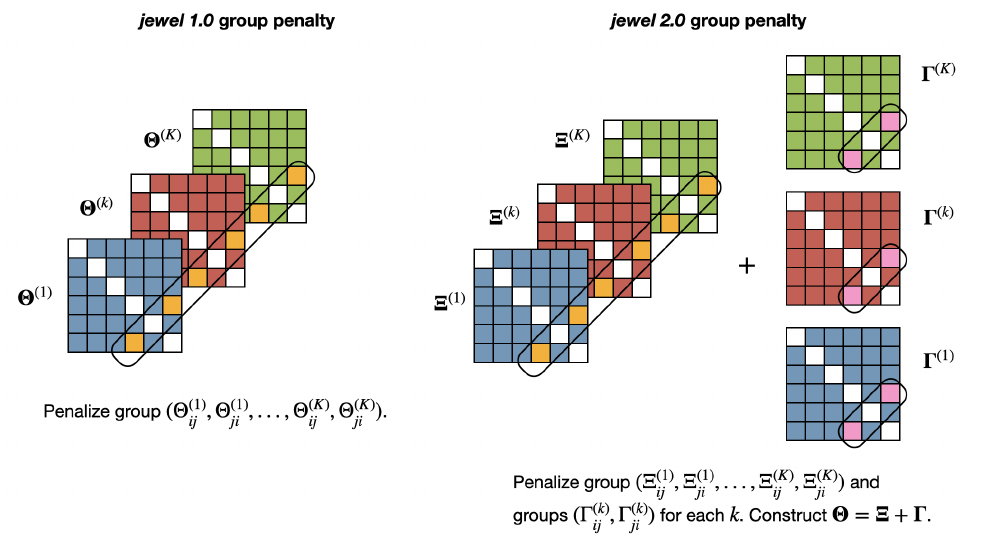
Figure 2. Illustration of the group penalties applied in jewel 1.0 ( left panel ) and jewel 2.0 ( right panel ). In jewel 1.0 , the penalty forces the datasets to share the same graph by either setting to zero or retaining the coefficients associated with the entire group ( Θ the first penalty is similar to the one in jewel 1.0 , applied to the entire group ( Ξ However, the second penalty is applied to each group ( Γ the approach to set to zero or retain edges in specific